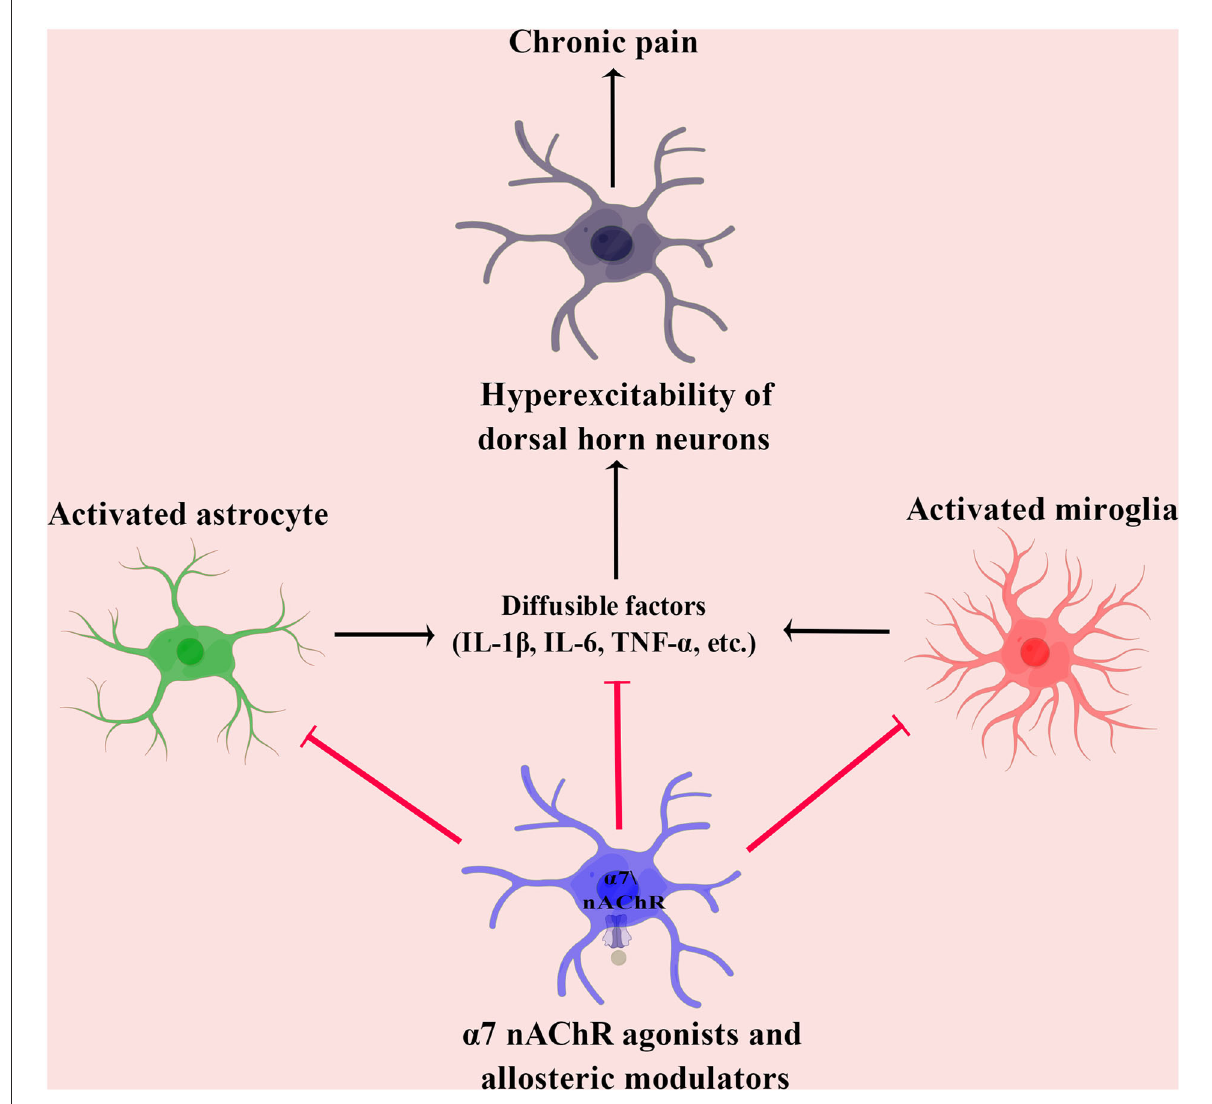
FIGURE1 In preclinical studies, the mechanisms underlying the analgesic effect of α 7 nAChR agonists and allosteric modulators in chronic pain. IL-1 β , interleukin 1 β ; IL-6, interleukin 6; nAChR, nicotinic acetylcholine receptor; and TNF- α , tumor necrosis factor- α